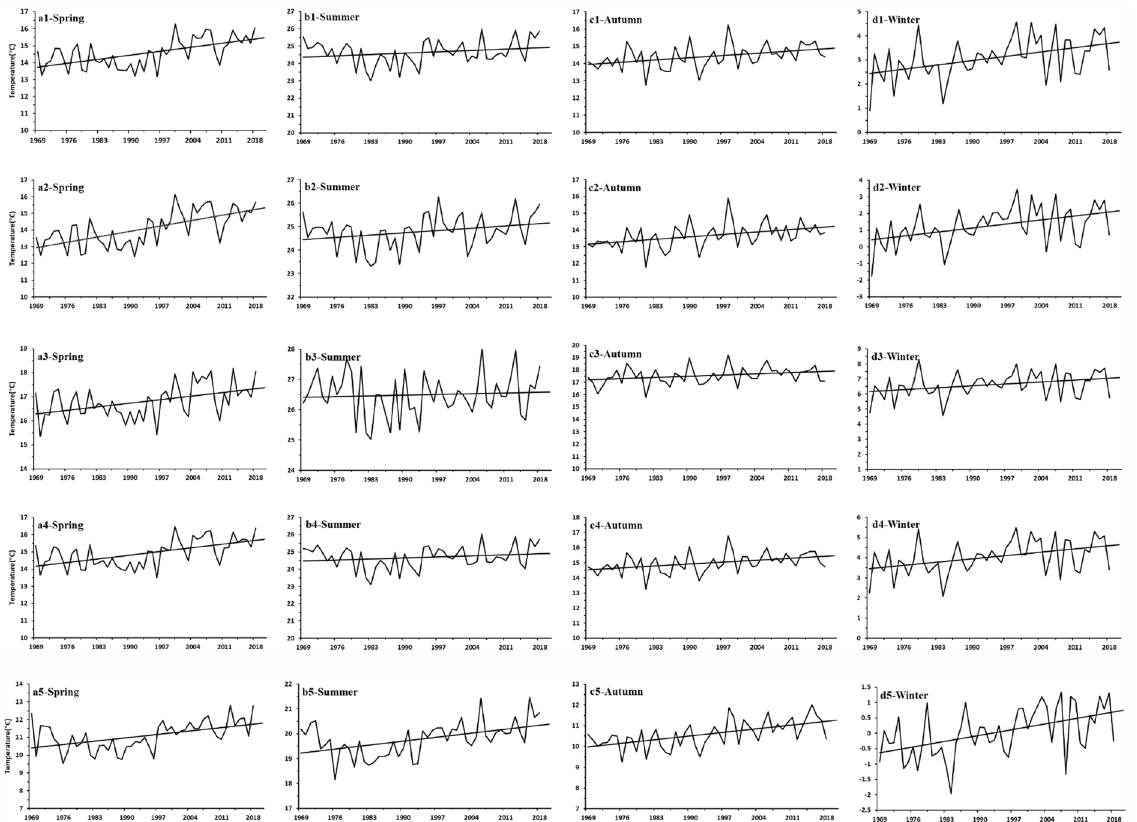
Figure 3. (From top row to bottom row) Variation in mean air temperature on the southern flank of the Qinling Mountains, the northern flank of the Qinling Mountains, the southern flank of the Daba Mountains, the northern flank of the Daba Mountains, and the western flank of the Qinling–Daba mountains ( a1 – a5 spring), ( b1 – b5 summer), ( c1 – c5 autumn), and ( d1 – d5 winter).